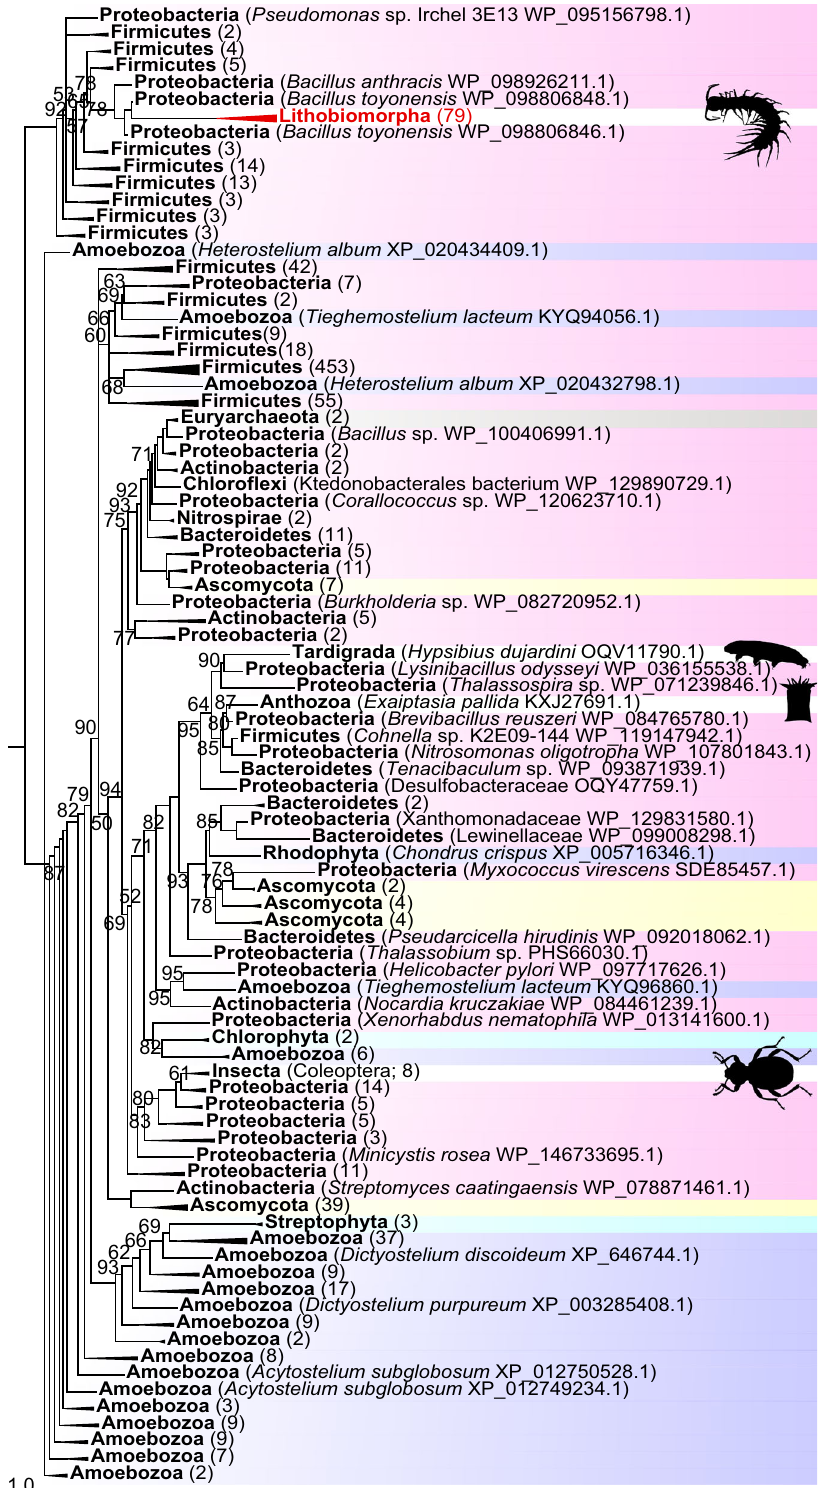
Fig. 2 A maximum likelihood tree of PCPDP-like sequences shows a clade of centipede sequences nested within a paraphyletic backbone of bacterial sequences. It shows that the centipede sequences originated from a bacterial HGT into the lithobiomorph lineage. Centipede sequences are coloured red. Highlighted sequences are Bacteria (pink), Viridiplantae (cyan), Protozoa (purple), Euryarchaeota (brown), and Fungi (yellow). Metazoan sequences are not highlighted. Collapsed clades have the number of included sequences indicated in parentheses. For the uncollapsed tree see Supplementary Fig. 2. The tree was reconstructed using the VT + G4 model and is displayed as midpoint rooted. Bootstrap support values are shown for each clade, and clades with support <50% are collapsed into polytomies. Clades without bootstrap values have >95% support. Non-centipede images are sourced from Phylopic